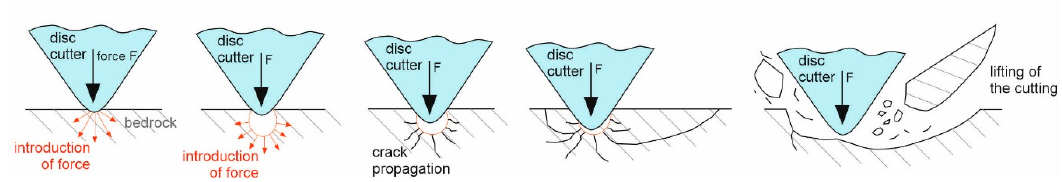
Figure 4. Chip-shaped rock removal by cutting discs according to [32].